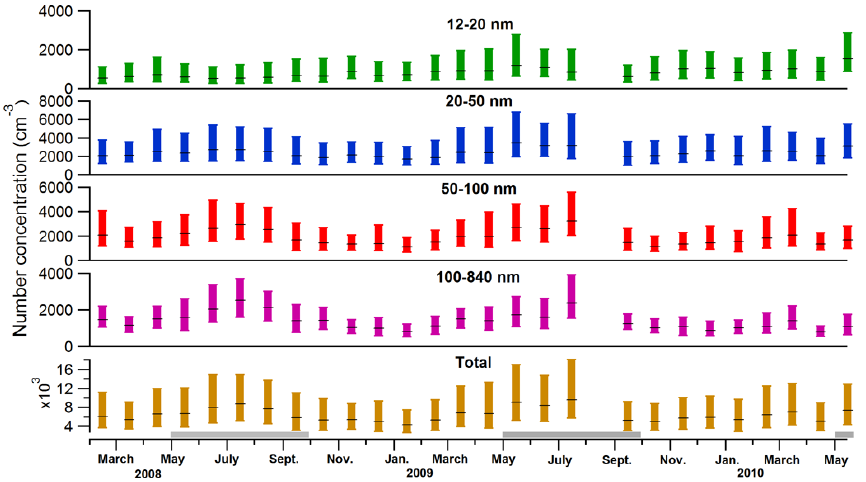
Fig. 4. Monthly median, 25% and 75% percentile concentrations of 12–20nm, 20–50, 50–100nm, 100–840nm, and 12–840nm (total) particles over two years. The dry periods are indicated with grey bars at the bottom of the figure.